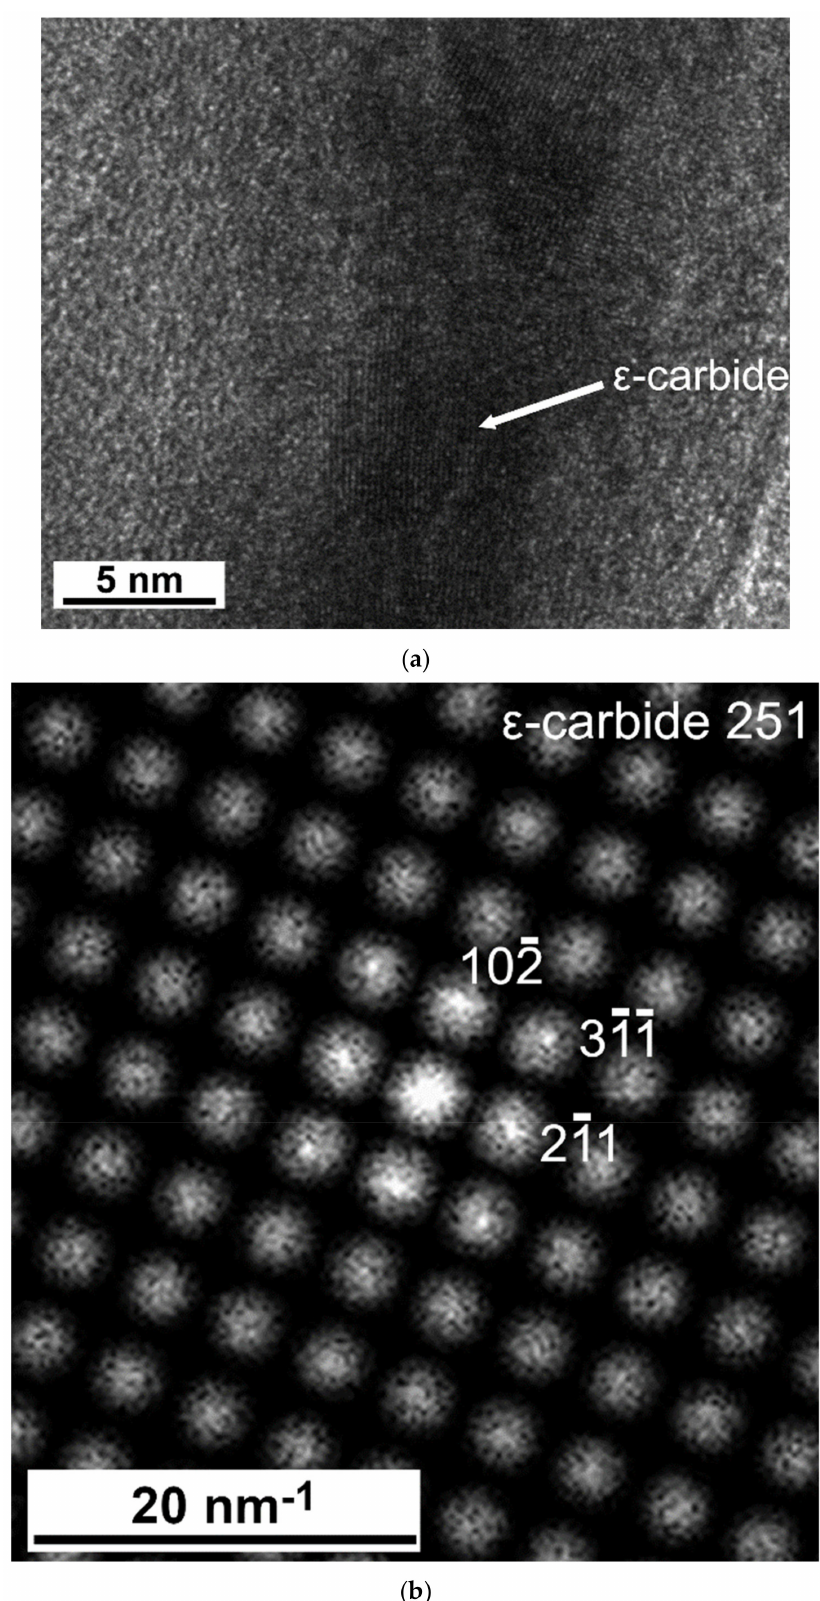
Figure 6. ( a ) HRTEM image of iron transition carbides in 42SiCr steel after tempering at 200 ◦ C, ( b ) A fast Fourier transform (FFT) diagram of the micrograph in ( a